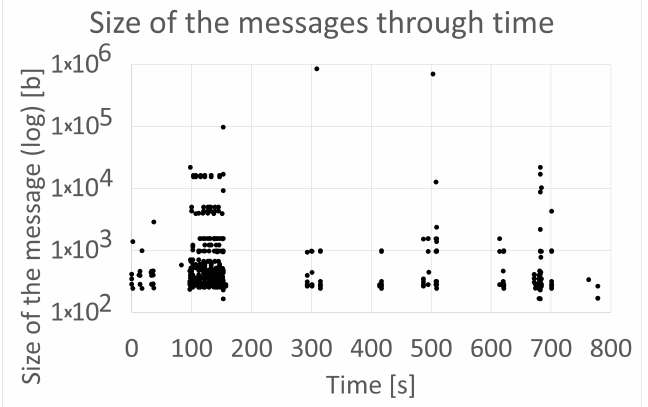
Figure 12. Size (in bytes) of messages sent at specific times.